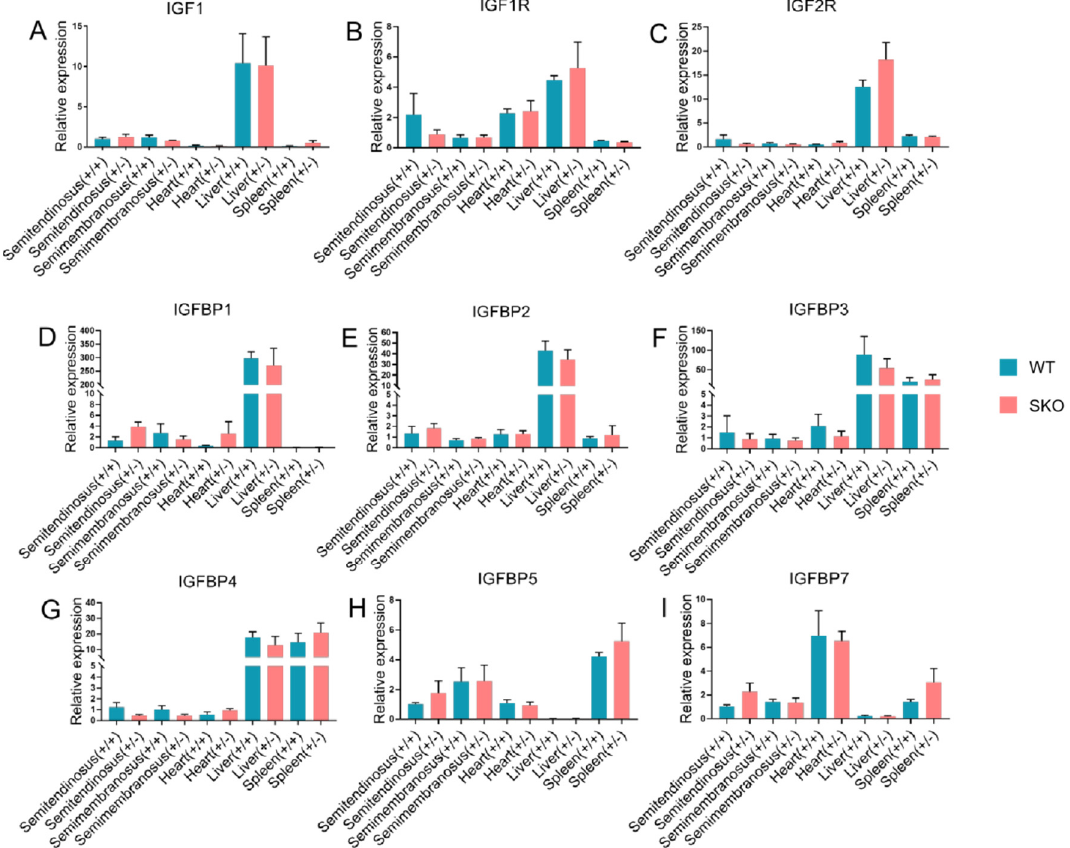
Figure 2. qPCR of IGF2 and related genes expression in ZBED6 -SKO and WT pig tissues. ( A ) The expression of IGF1 in five tissues of ZBED6 -SKO and WT pigs. ( B ) The expression of IGF1R in five tissues of ZBED6 -SKO and WT pigs. ( C ) The expression of IGF2R in five tissues of ZBED6 -SKO and WT pigs. ( D ) The expression of IGFBP1 in five tissues of ZBED6 -SKO and WT pigs. ( E ) The expression of IGFBP2 in five tissues of ZBED6 -SKO and WT pigs. ( F ) The expression of IGFBP3 in five tissues of ZBED6 -SKO and WT pigs. ( G ) The expression of IGFBP4 in five tissues of ZBED6 -SKO and WT pigs. ( H ) The expression of IGFBP5 in five tissues of ZBED6 -SKO and WT pigs. ( I ) The expression of IGFBP7 in five tissues of ZBED6 -SKO and WT pigs. Notes: IGF1: insulin-like growth factor 1; IGF1R: insulin like growth factor 1 receptor; IGF2R: insulin like growth factor 2 receptor; IGFBP 1-7: insulin-like growth factor binding protein 1-7; SKO: one allele knockout; WT: wild type; (+/+): wild type; (+/-): single knock type.